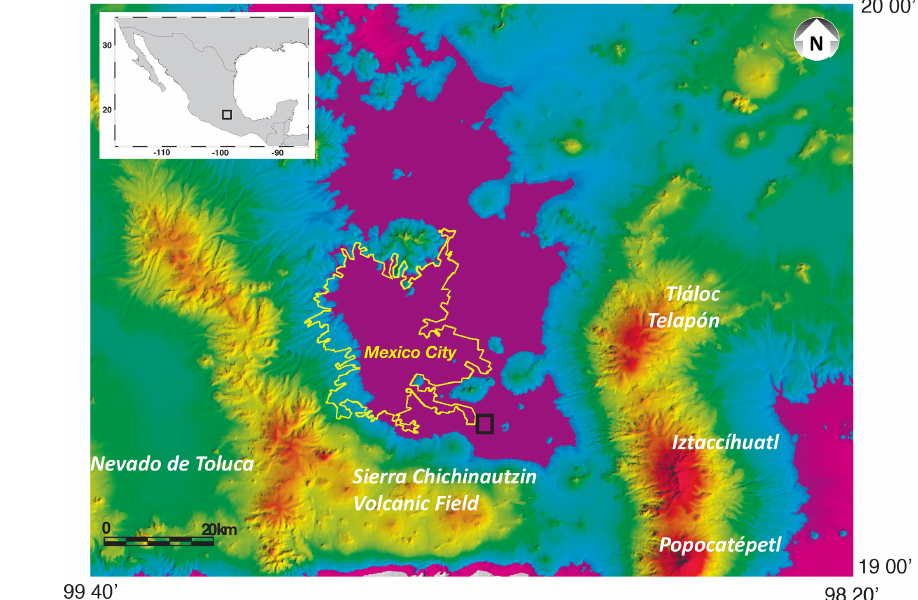
Figure 1. Site map of the Basin of Mexico, showing the extent of the paleolake (flat magenta areas), the developed areas of the megalopolis, and locations of coring sites in Chalco (black box).